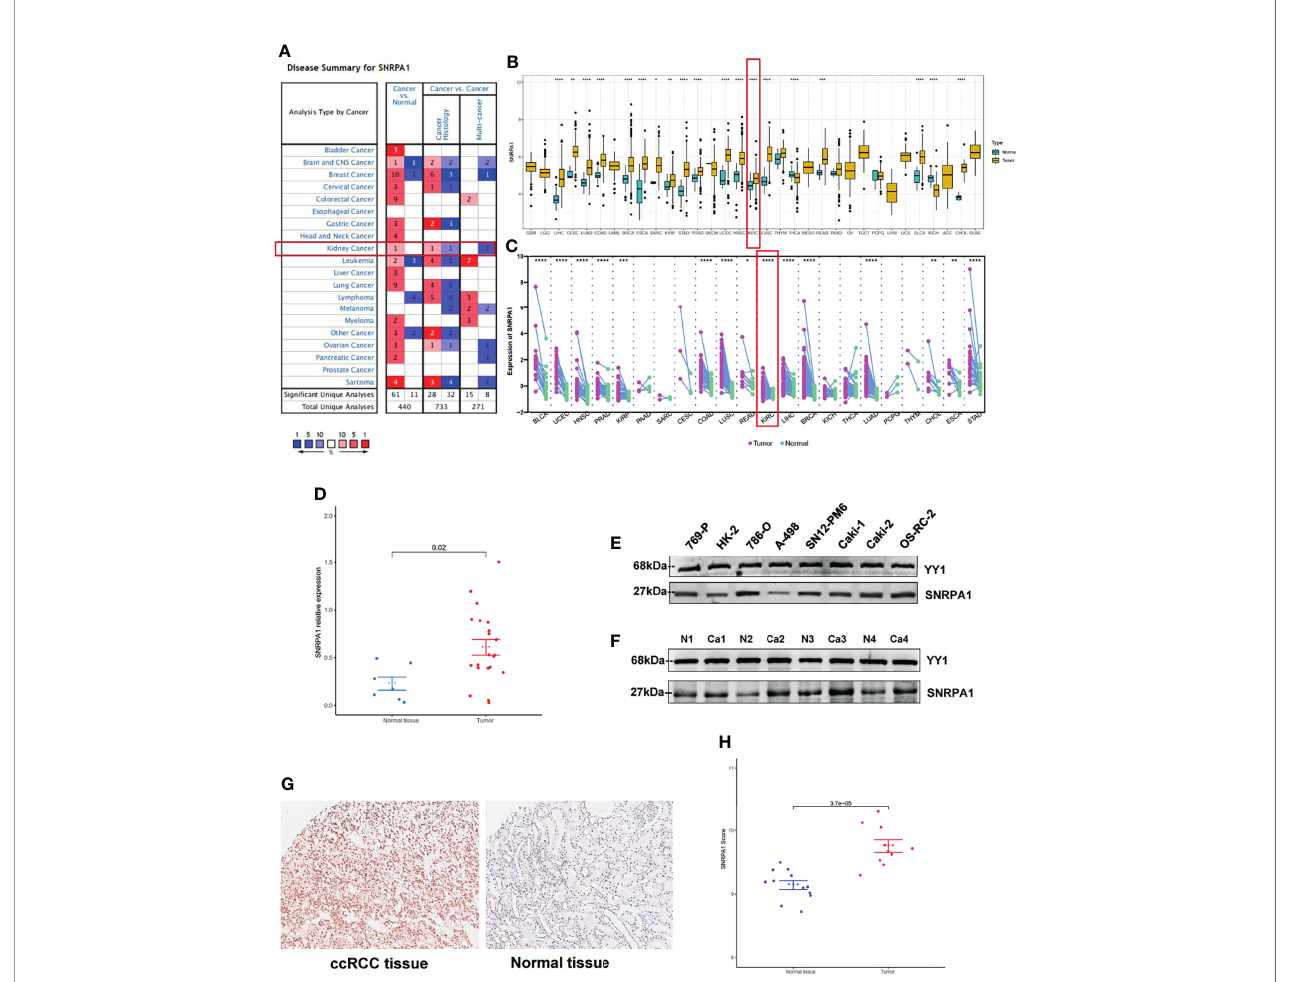
FIGURE 1 | Elevated expression pattern of SNRPA1 in ccRCC. (A) Expression of SNRPA1 in 20 different cancer types from the Oncomine database. (B) Differential expression of SNRPA1 in 33 cancer types from the TCGA database. (C) Differential expression of SNRPA1 in paired cancer and normal tissues of 22 cancer types from the TCGA database, *p < 0.05, **p < 0.01, ***p < 0.001, ****p < 0.0001. (D) RT-PCR result of SNRPA1 expression in renal cancer and adjacent normal tissue from Changzheng Hospital, n = 40, p < 0.01. (E) Western blotting of SNRPA1 differential expression in kidney normal and tumor cell lines. (F) Western blotting of SNRPA1 differential expression in tumor tissue and adjacent normal tissue from ccRCC patients. (G) Representative immunohistochemical images of SNRPA1 expression in ccRCC and adjacent tissues from Changzheng Hospital, scale bar = 50 m m. (H) Quanti fi cation of the H-score for SNRPA1 protein level assessed by immunohistochemical